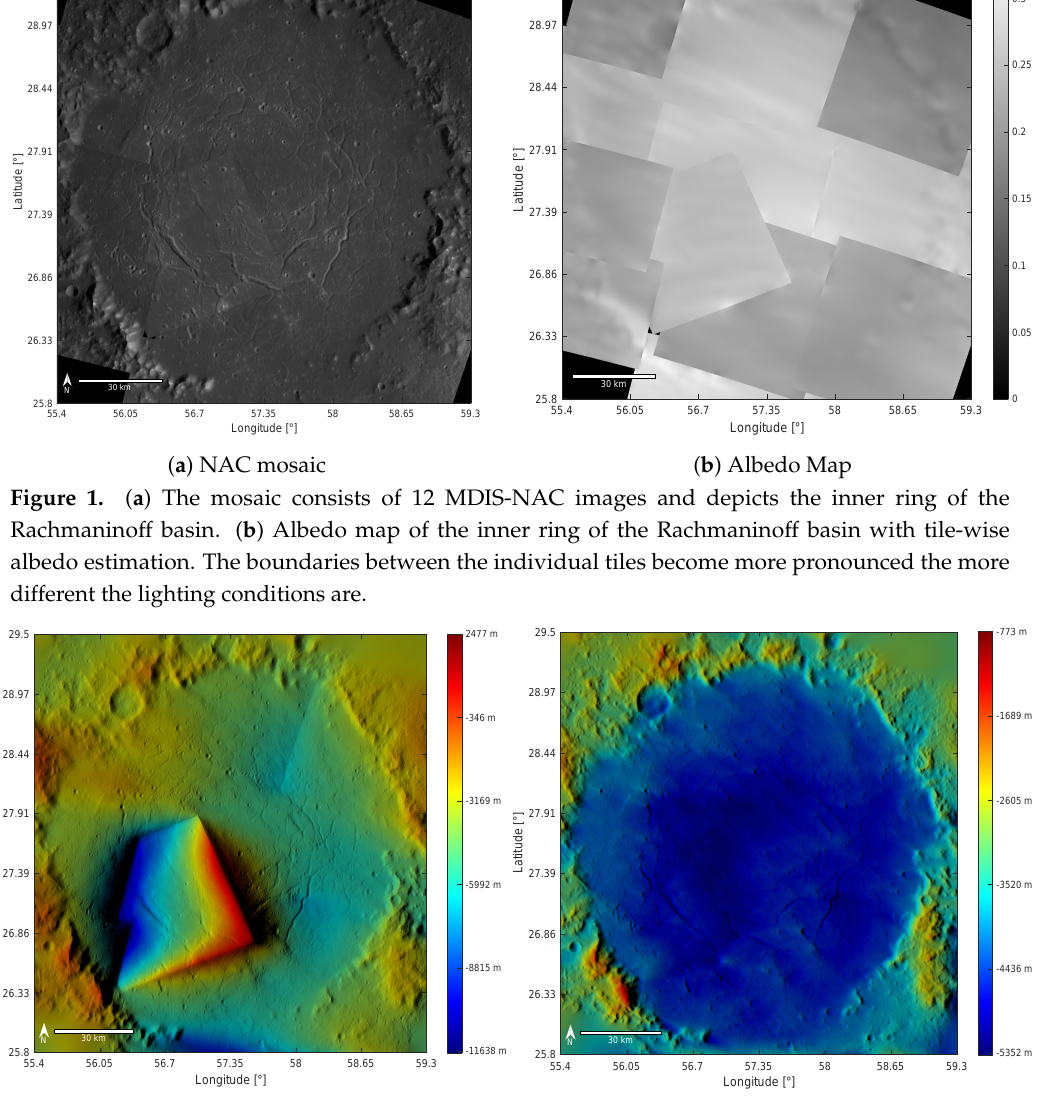
Figure 2. Effects of the old and new albedo estimation on the DTM generated from the mosaic in Figure 1a. ( a ) The albedo at each pyramid level is calculated for the entire image. The resulting DTM shows strong distortions at the tile boundaries with large differences in reflectance. ( b ) The albedo is calculated independently for each mosaic tile. No edges are visible at the original image boundaries, resulting in a much more realistic